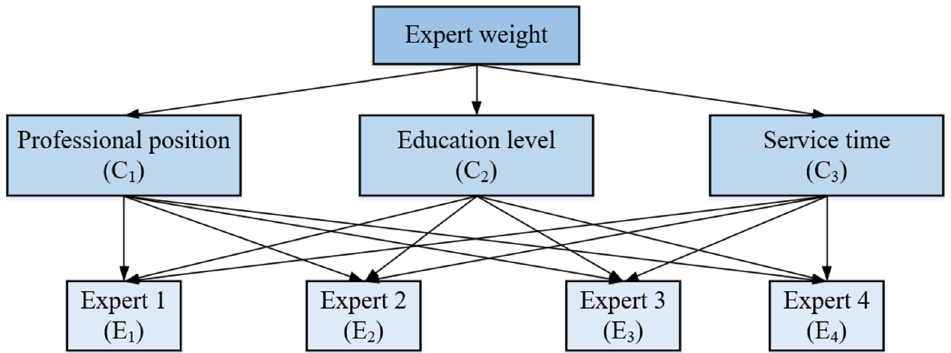
Figure 5. Three-level hierarchical structure of judging expert weights.